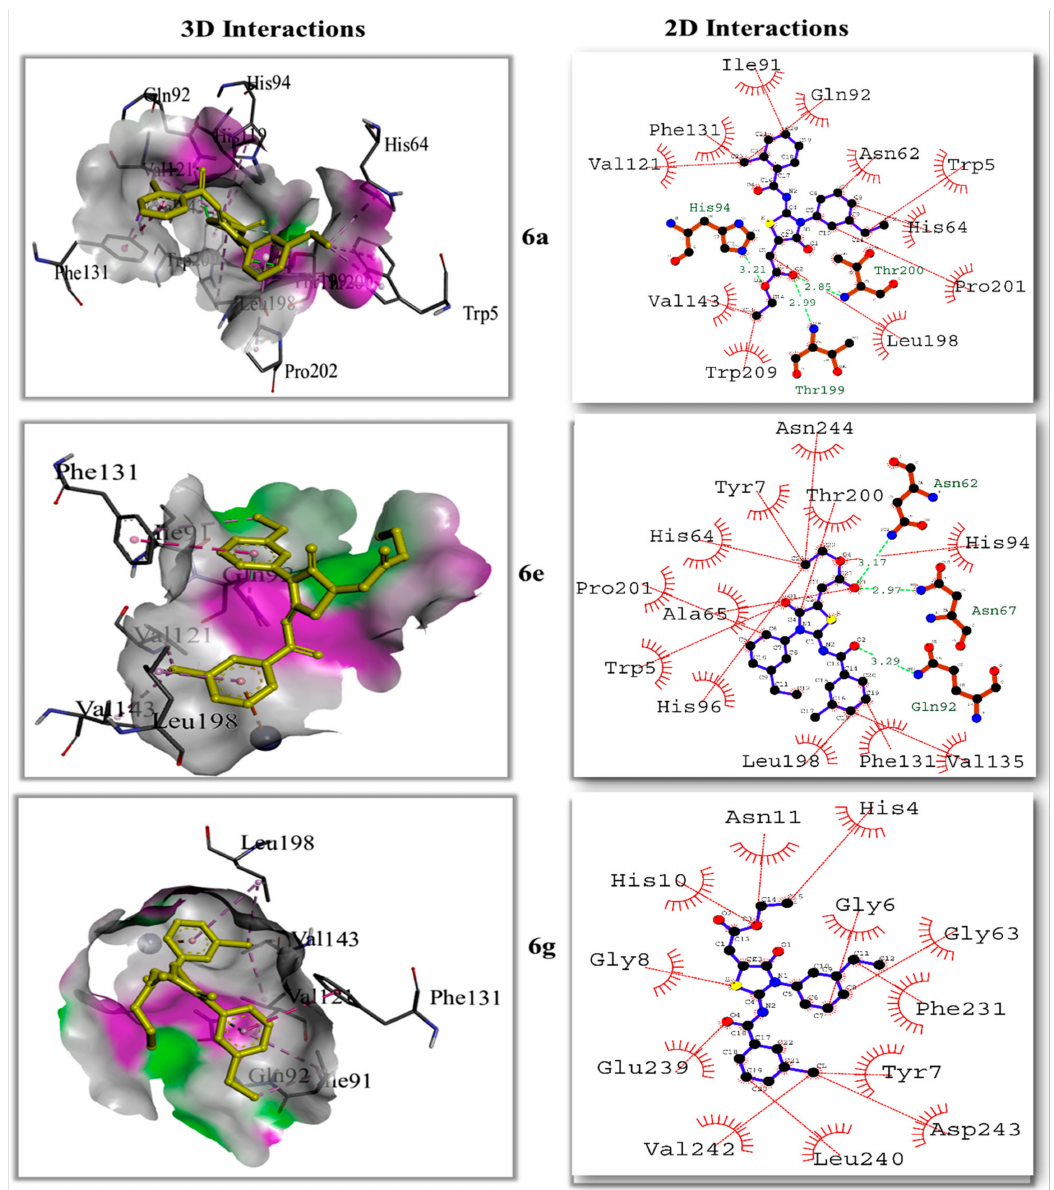
Figure 7. The predicted 2D and 3D interactions of compounds 6a , 6e and 6g within the active pocket of